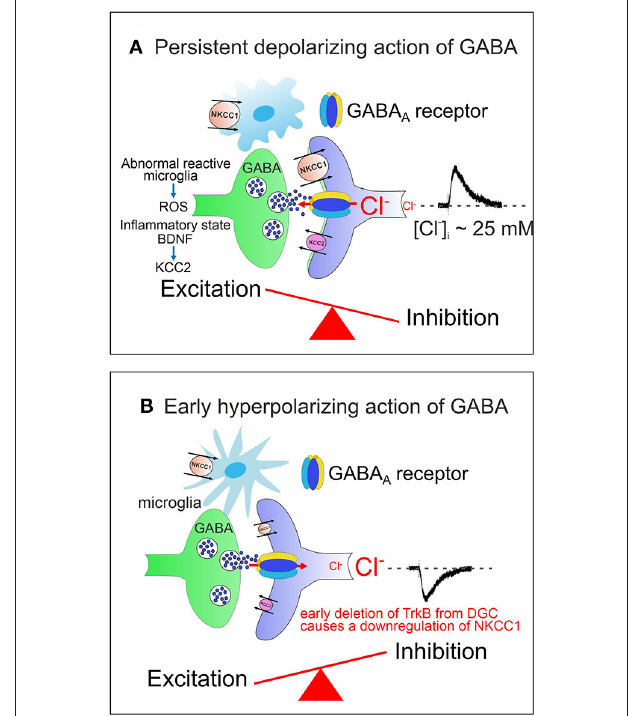
FIGURE 2 | Alterations in developmental GABA shift lead to neuropsychiatric disorders. (A) The persistent depolarizing action of GABA beyond the critical period, impairs network excitability and the E/I balance. Abnormal reactive microglia, produces high levels of ROS, often associated with an inflammatory state caused by a dysfunction of the immune system. BDNF, released from microglia contributes to downregulate KCC2 with consequent enhancement of network excitability. (B) The early hyperpolarizing action of GABA at birth, caused by the reduced expression of NKCC1, following deletion of TrkB from immature DGCs, at the time when these cells integrate the classical tri-synaptic pathway, severely alters the morphology and circuitry downstream of DGCs. In (A,B) both pre (GABAergic interneurons, green) and post synaptic (targeted cells, violet) elements are represented. Red arrows indicate the direction of Cl − flux through GABA A receptor